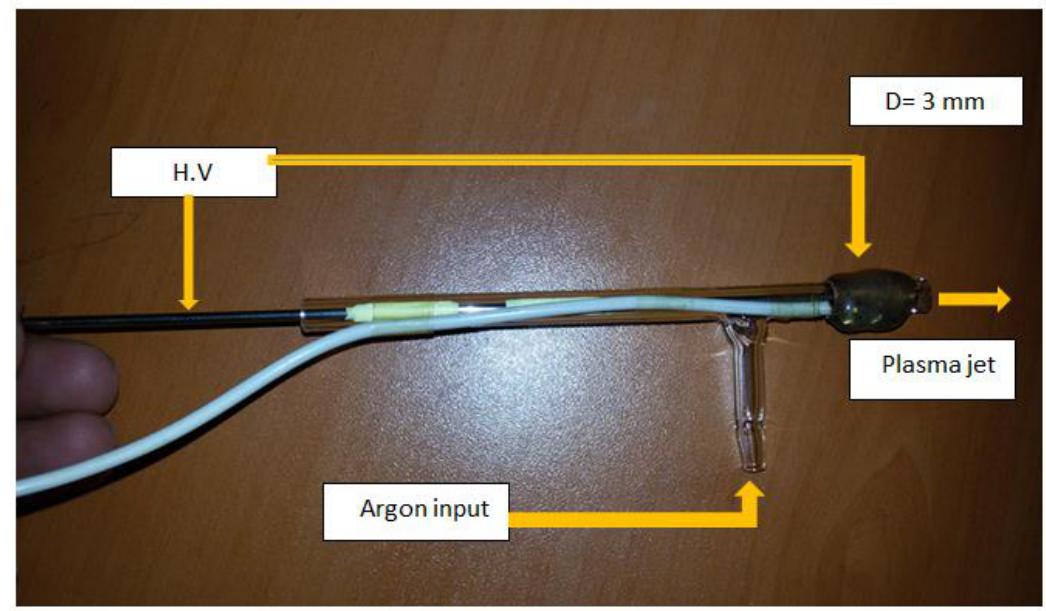
Fig. 1: The non-thermal plasma needle